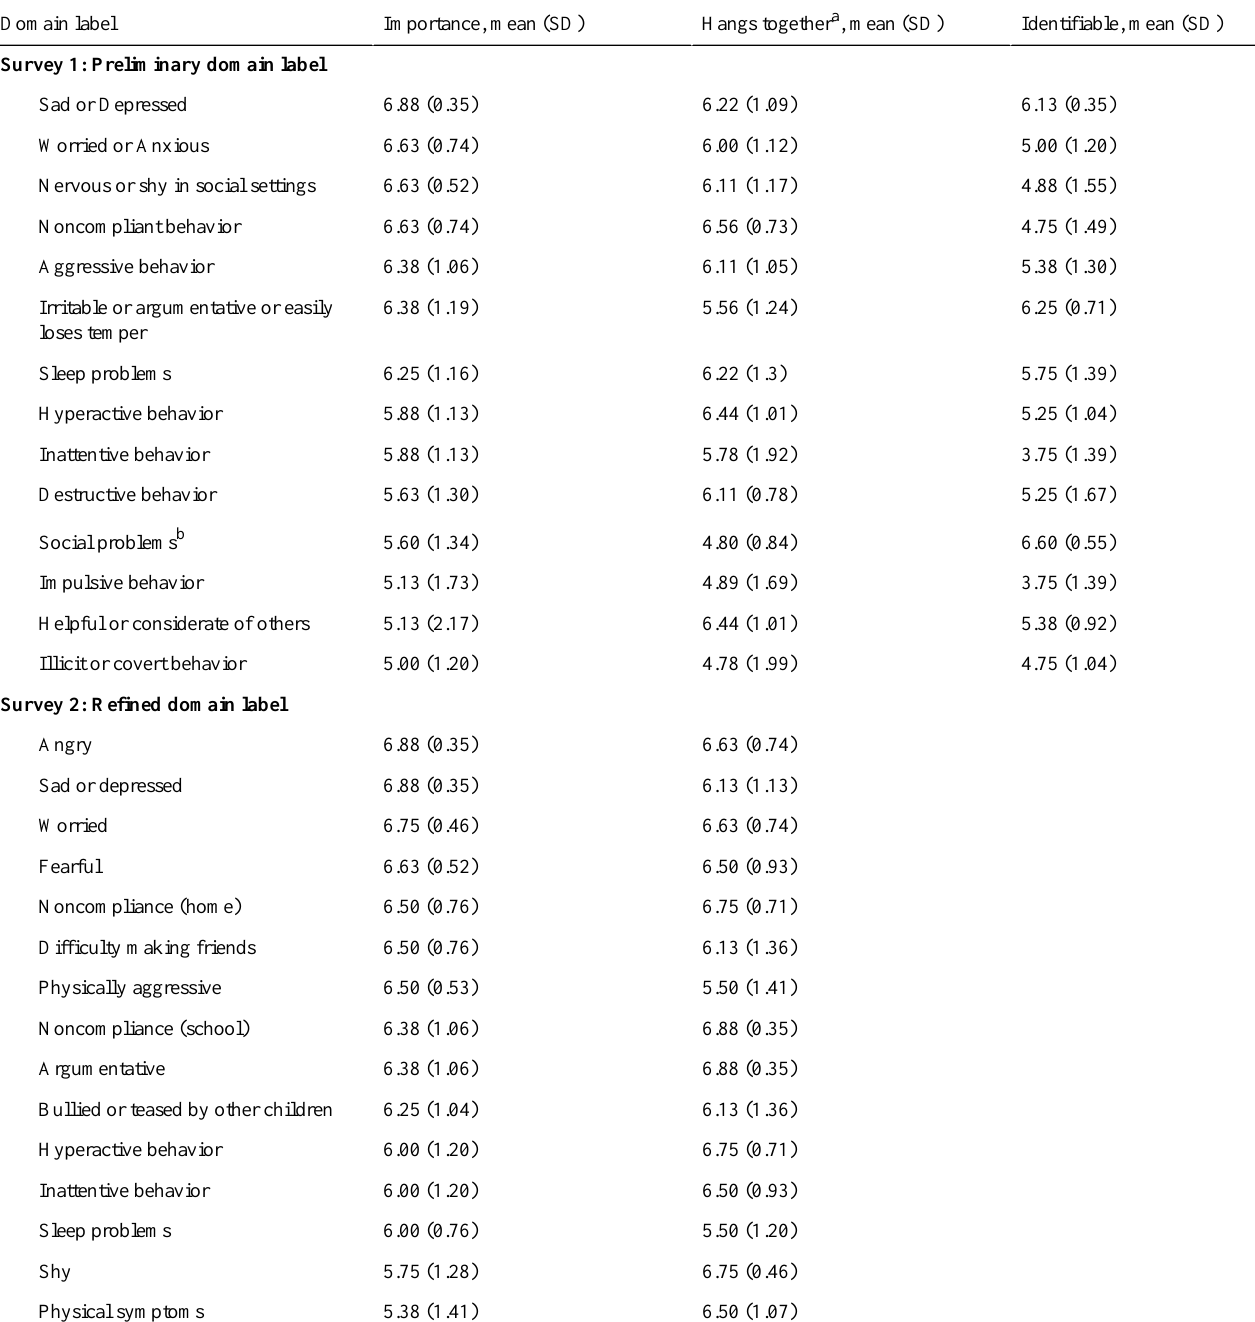
Table 1. Ratings for constructs based on initial expert panel review, ordered from most (7) to least (1) perceived importance for a screening instrument.